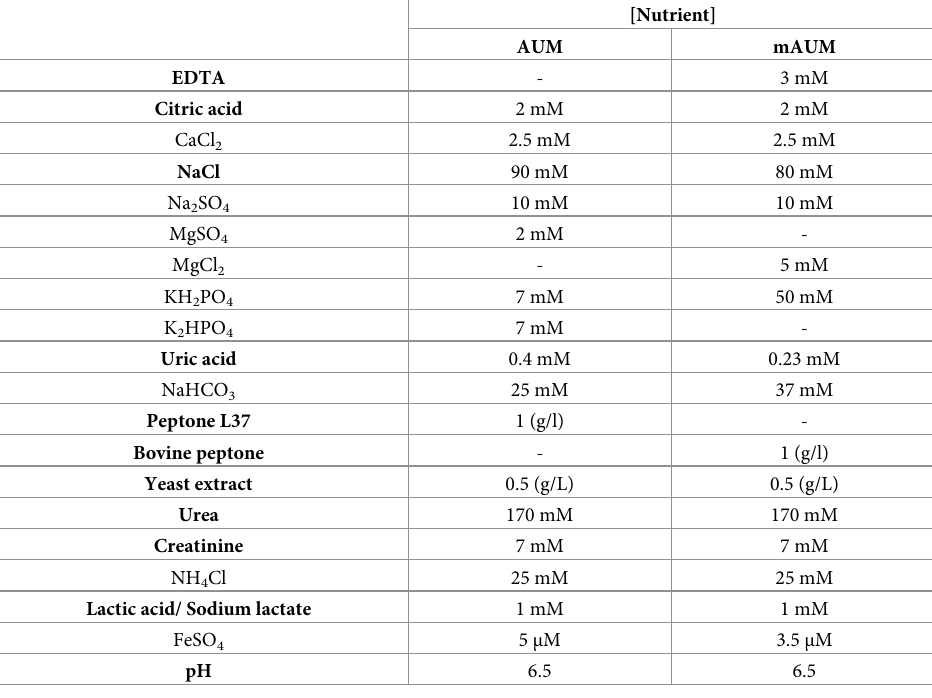
Table 1. Comparison of artificial urine and modified artificial urine